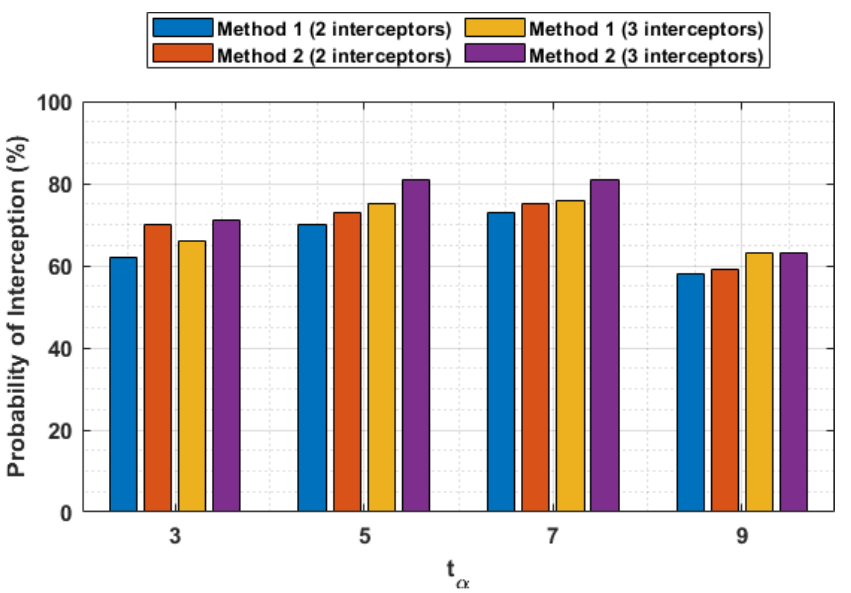
Figure 14. Comparison of probability of interception for all t α , in Case